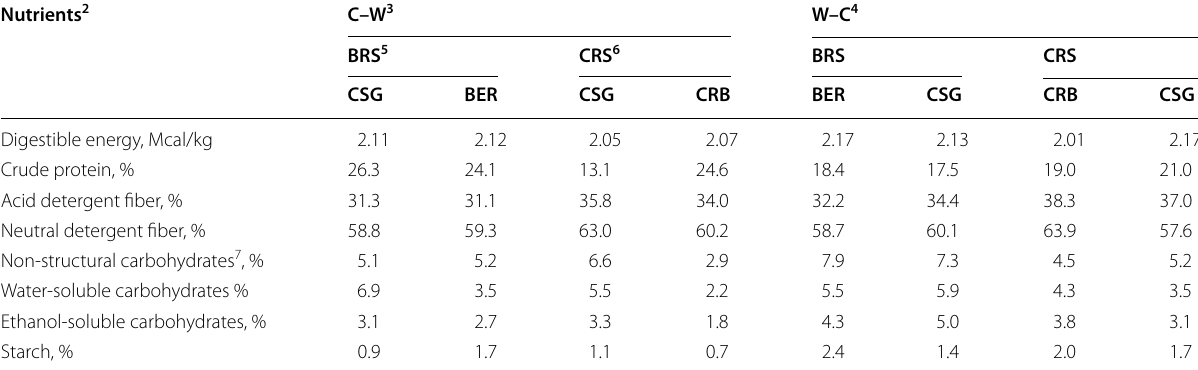
Table 5 Nutrient composition 1 of pasture